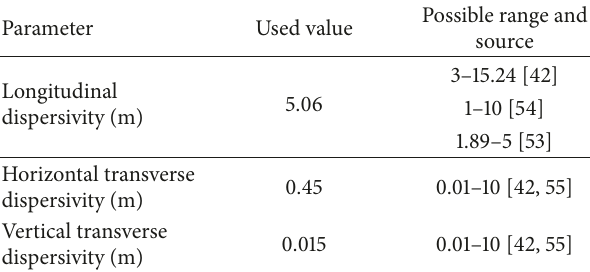
Table 3: Dispersivity values used in MT3D.